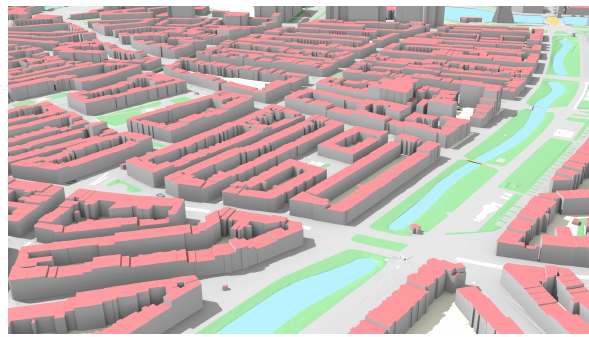
Figure 2. 3D city model of Rotterdam (LOD1). The model was generated with 3dfier (open source software by TU Delft).